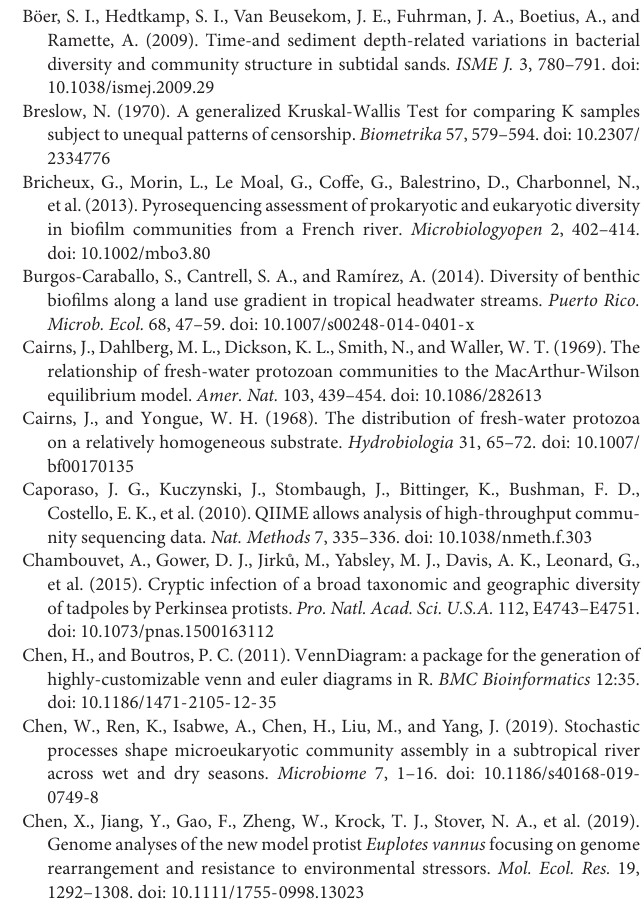
FIGURE S1 | The boxplots for richness and Shannon-Wiener index of between different environment (Lake vs. River) and different water columns in river (WH vs. WL). FIGURE S2 | RDA ordination showing the microbial eukaryotic community structures of glass slides (A) , PFUs (B) and water columns (C) in lake and river in relation to environmental factors. Tem, temperature; pH; DO, dissolved oxygen; TN, total nitrogen; TP, total phosphorus; AN, ammonia nitrogen; COD, chemical oxygen demand. The black characters represent samples, blue arrows represent measured environmental